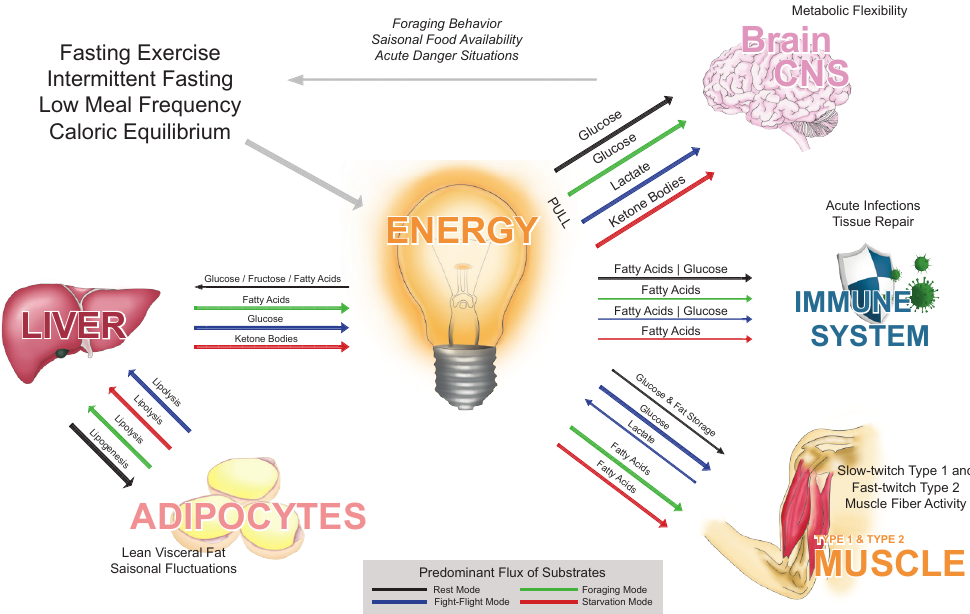
Figure 1. Metabolic flexibility in the hunter-gatherer lifestyle. The brain orchestrates its energy needs by either “pulling” energy from storage organs (from inside the body) in the daily foraging mode, in the short-term fight-flight mode or during long-term hunger in the starvation mode. If food is available, the brain is supplied with energy substrates through a “push” of nutrients (from outside the body) in the rest mode. If all programs are activated occasionally, the metabolic system holds the energetic equilibrium and body weight remains